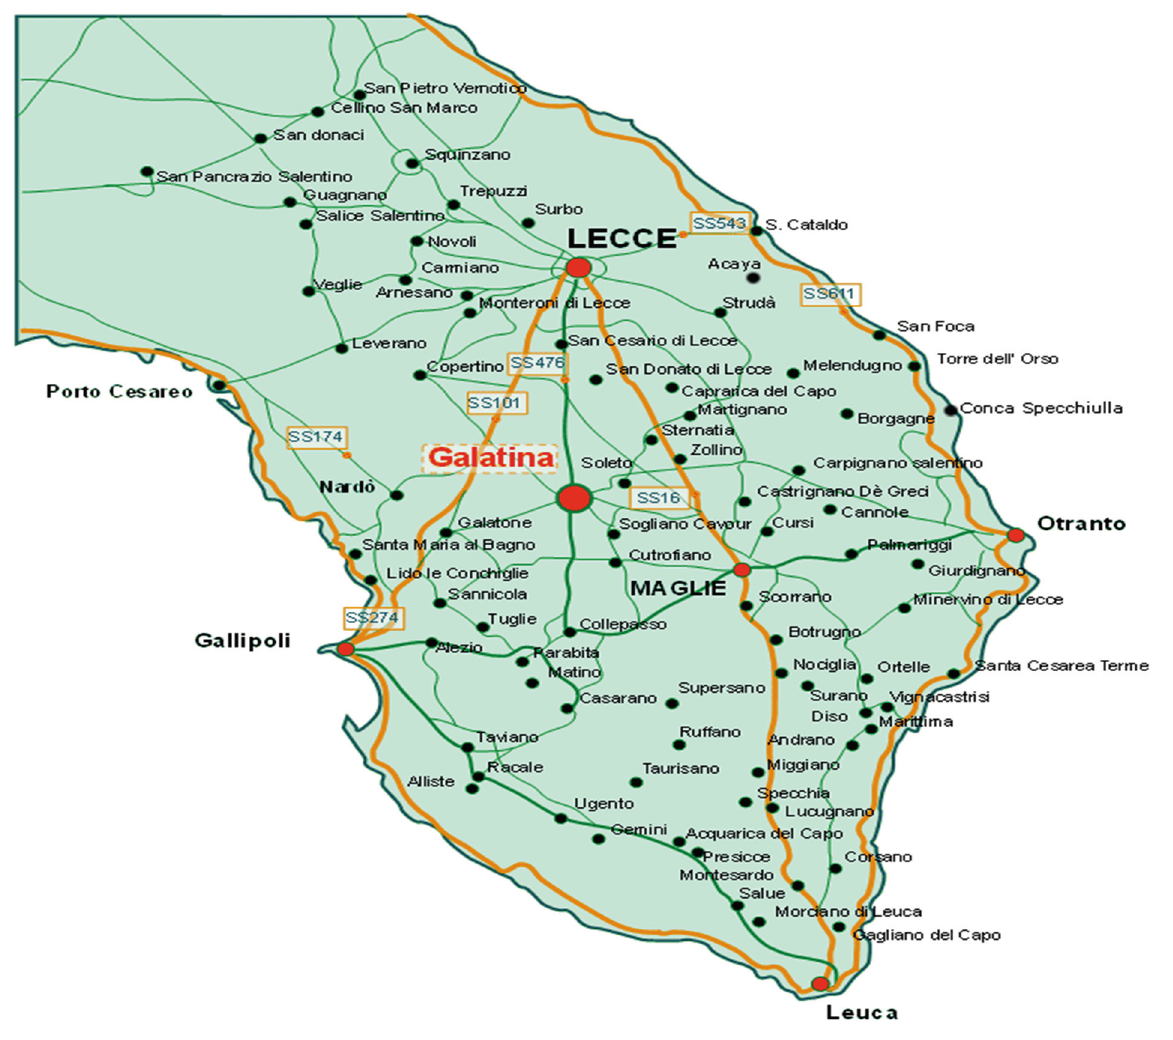
Figure 1. Map of Southern Puglia showing the area surveyed during the present